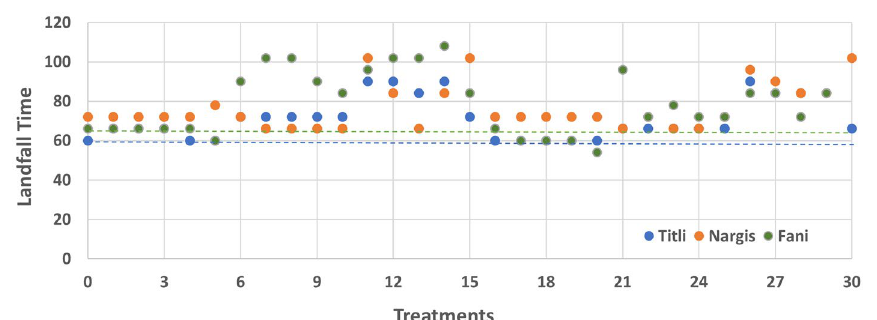
Figure 2. Landfall time for three cyclones Fani, Titli, and Nargis for different combination of schemes.